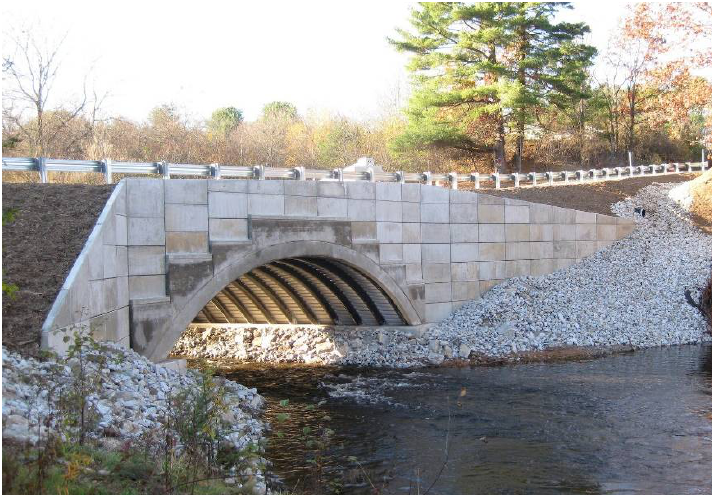
Figure 2. Royal River Bridge in Auburn (USA) with a span of 11.6 m, composed of 13 concrete-filled FRP curved tubes [20].